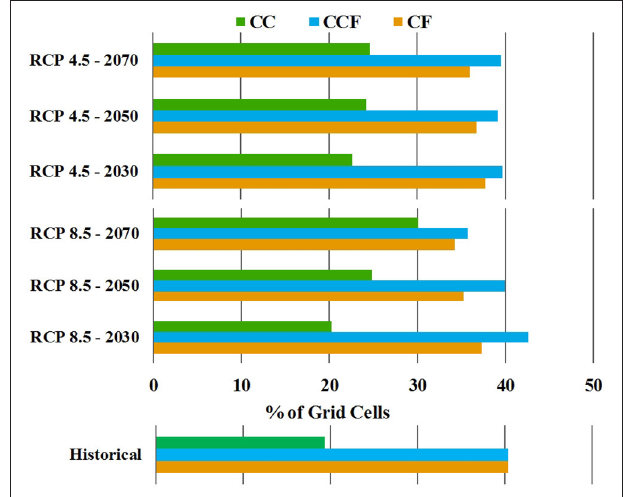
FIGURE 6 | Percent of grid cells in the Inland Pacific Northwest assigned to a given agroecological class (crop/fallow (CF), annual crop/fallow transition (CCF), and continuous cropping (CC)) for baseline (1979-2010) and future periods (2030s, 2050s and 2070s) under representative concentration pathways (RCP) 4.5 and 8.5. Results are the average of 12 global climate